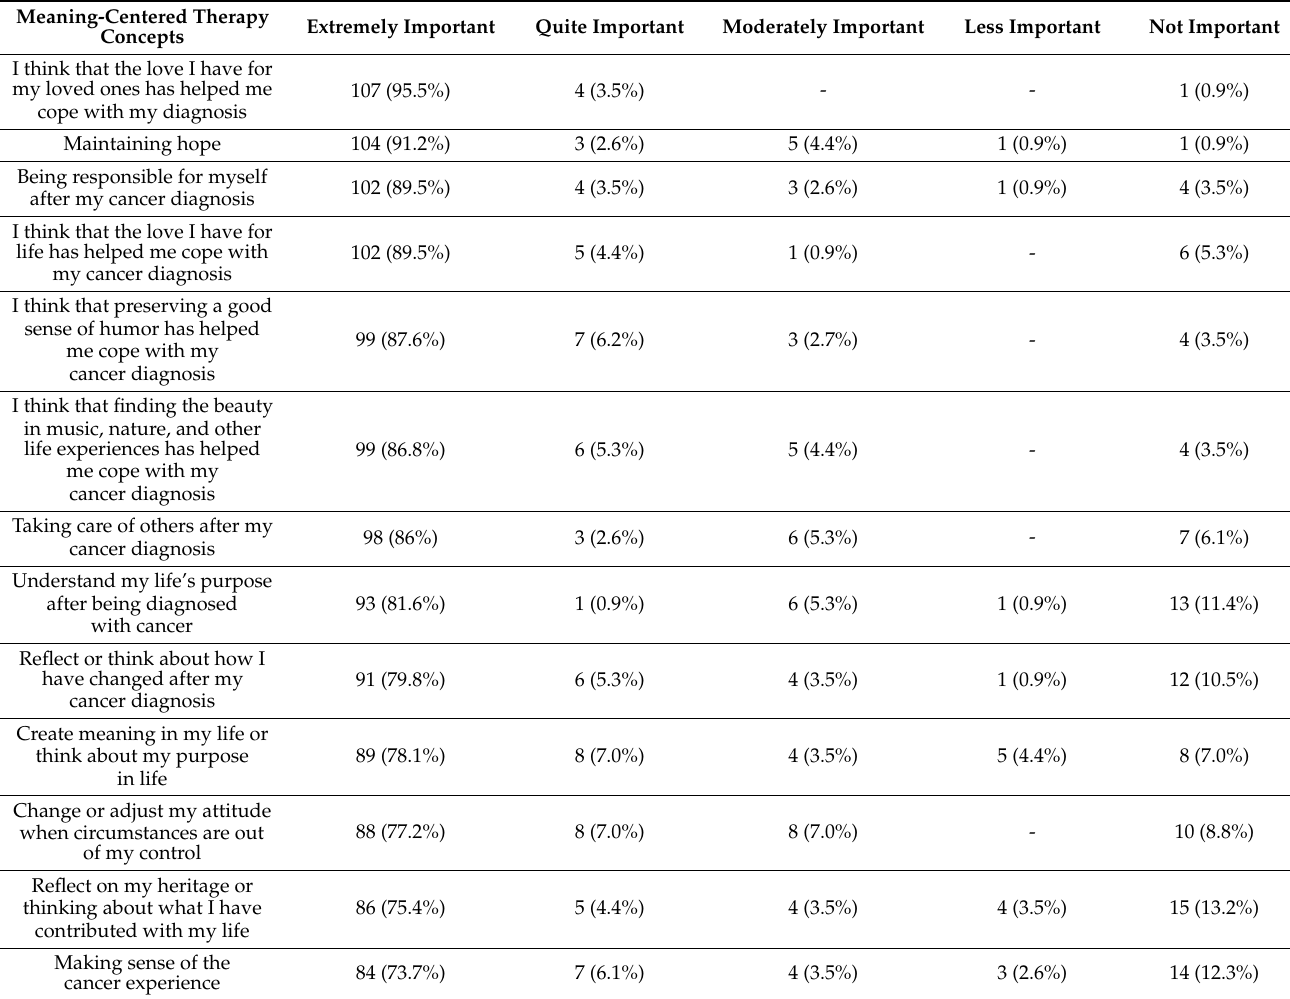
Table 2. Meaning-centered psychotherapy concepts: